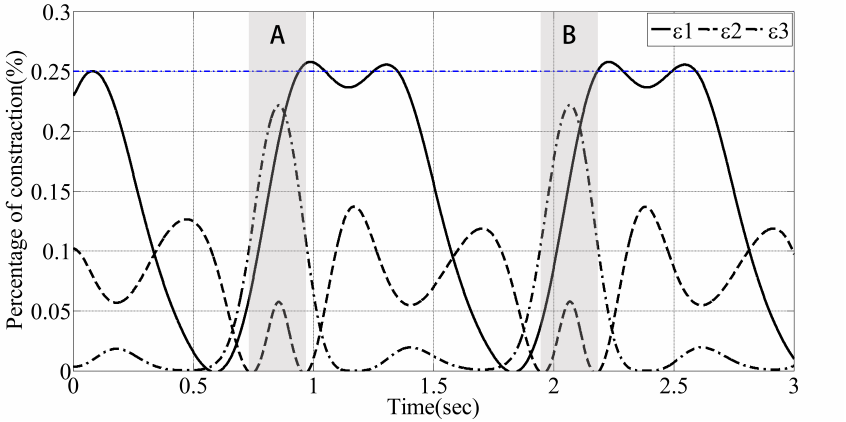
Figure 16. The trajectory of three pneumatic muscles during the assisting